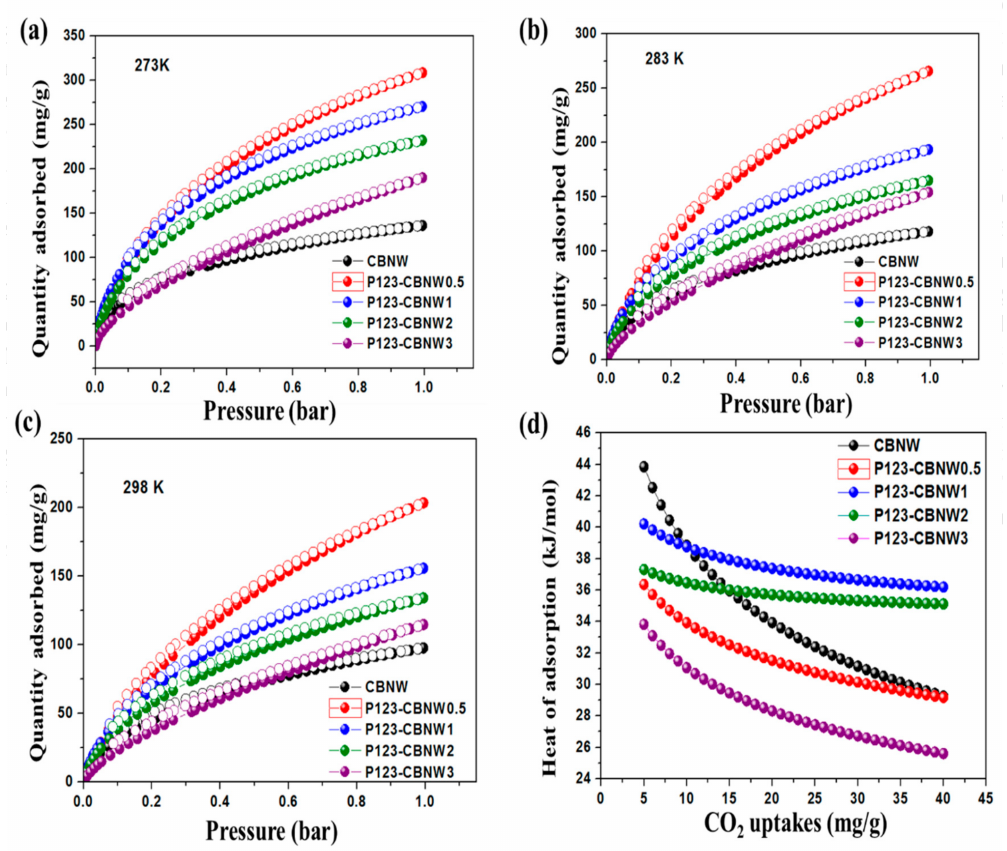
Figure 7. Adsorption, desorption isotherm of CO 2 on prepared adsorbent materials at 273 K ( a ), 283 K ( b ), 298 K ( c ) and heat of adsorption of all materials ( d ). Table 3. CO 2 and N 2 gas uptake by the prepared samples at di ff erent temperatures at 1 bar pressure.